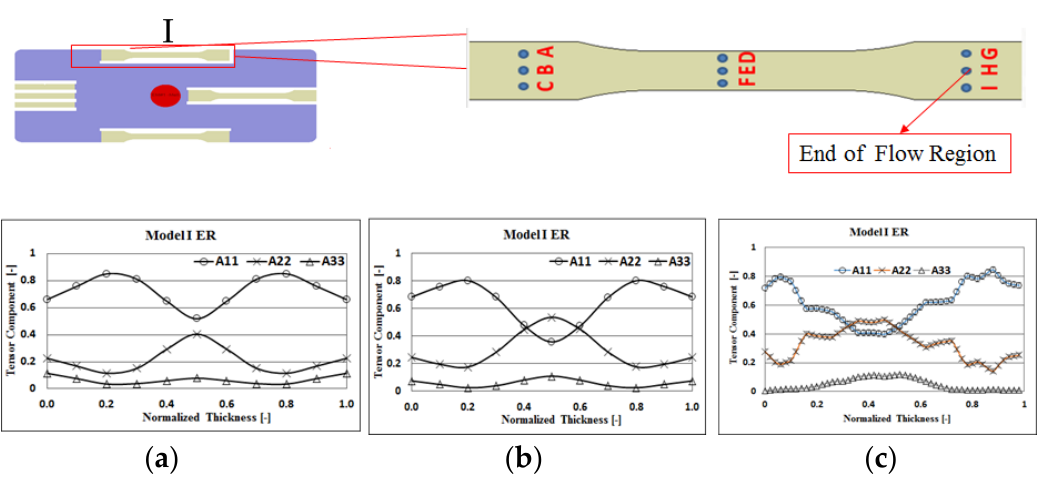
Figure 9. The comparison of the fiber orientation tensor components for Model I at Point H at ER: ( a ) simulation without flow–fiber coupling, ( b ) simulation with flow–fiber coupling, ( c ) experimental observation.